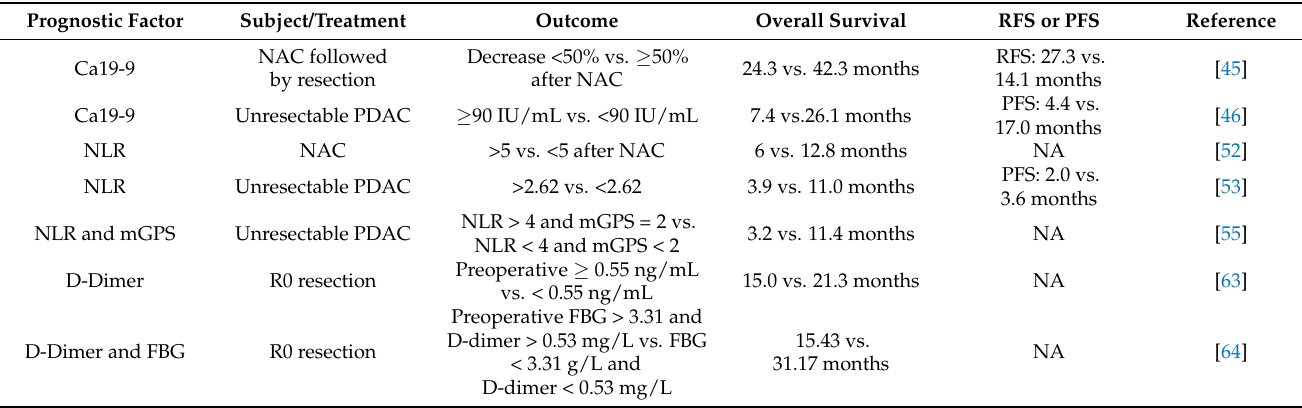
Table 2. Survival and recurrence-free survival outcome of PDAC